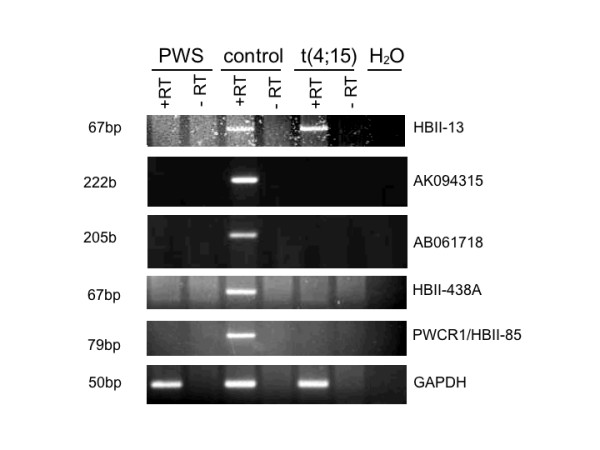
Expression analysis in LCLs of snoRNAs and two ESTs in intron 20 . RT-PCR analysis of the C/D box snoRNAs reveals expression of HBII-13, but not of HBII-438A/B, PWCR1/HBII-85 and the two ESTs in intron 20 in the t(4;15) translocation carrier. +RT: with reverse transcriptase; -RT: without reverse transcriptase; H2O: no template control.